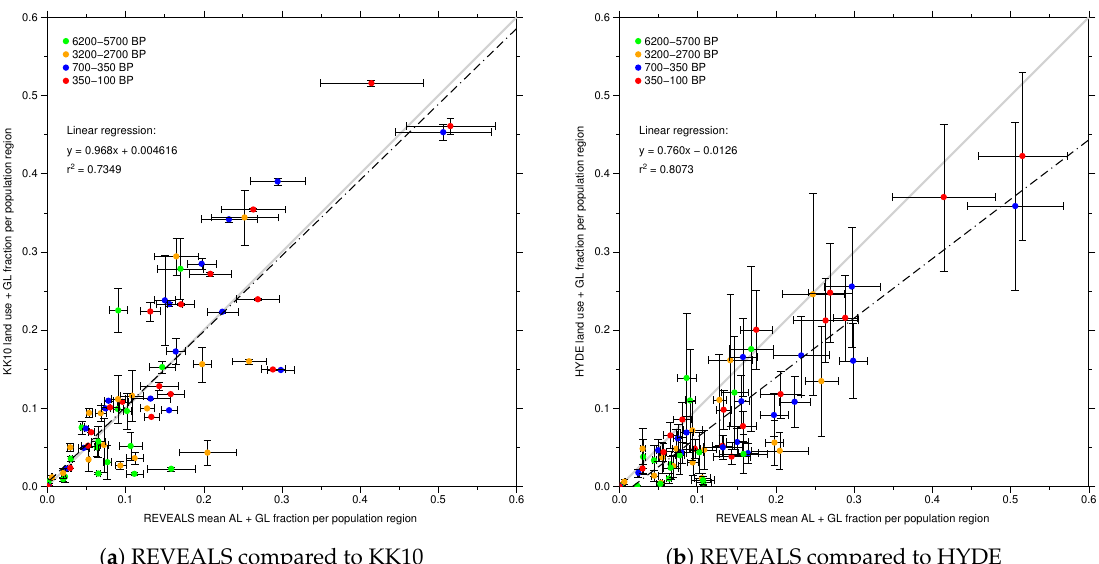
Figure 5. Comparison between REVEALS and the ALCC scenarios at the population region scale. REVEALS open land fraction is plotted against land use + non-forest fractions for ( a ) KK10 and ( b ) HYDE. The dashed line is a linear regression through the data, while the 1:1 line is shown in light gray. The vertical error bars in the KK10 correlation indicate the range associated with the six possible KK10 scenarios, while for HYDE the error bars reflect the authors’ published temporally-varying uncertainty estimate (see